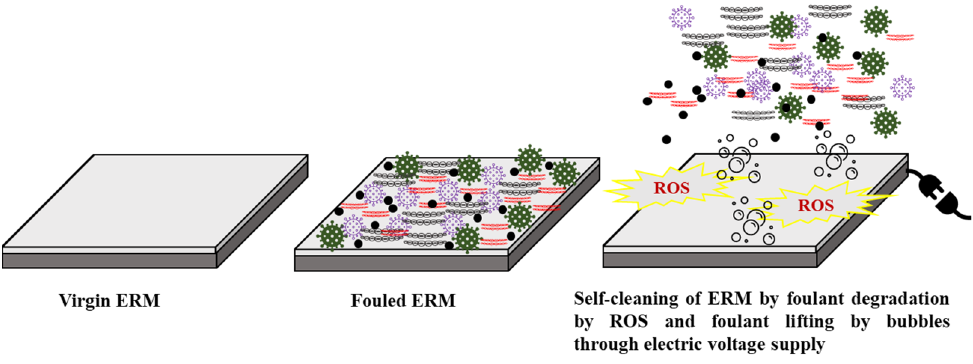
Figure 6. An illustration of the self-cleaning properties of ERMs by applying an electric current.